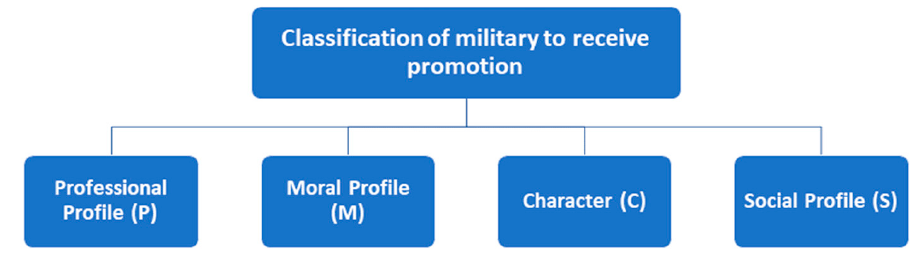
Figure 4. Presentation of the objective and criteria of the problem.